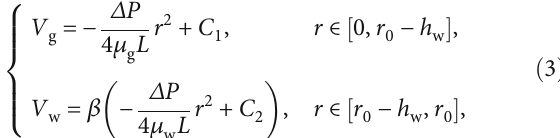
= 2 nm , 0 is the gas slip s